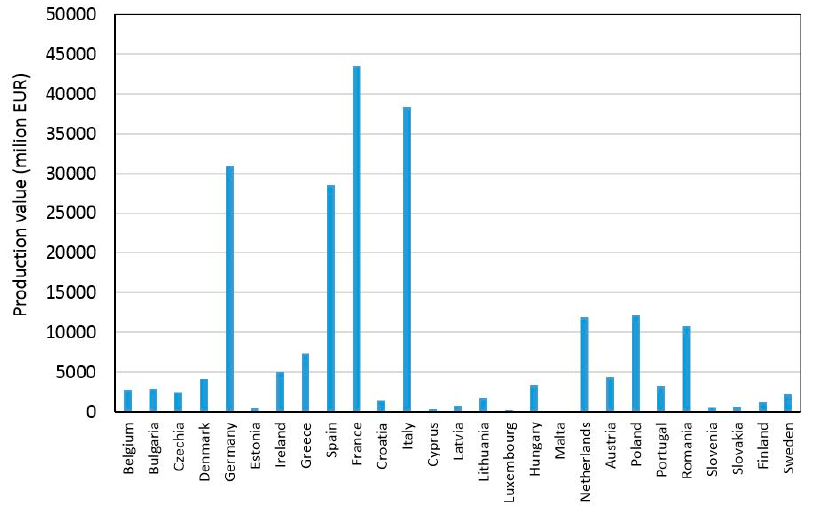
Figure 25. Gross value added of agriculture at basic prices in the member countries of the EU in 2020, data from Eurostat [70].